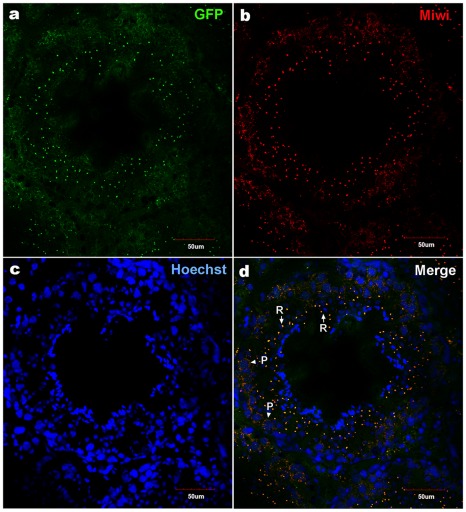
Co-localization of transgenic Miwi-EGFP and endogenous Miwi in transgenic mouse.Transgenic Miwi-EGFP and endogenous Miwi proteins in the Miwi-EGFP transgenic mouse testis were examined by indirect immunofluorescence and confocal microscopy using anti-GFP and anti-Miwi antibodies. Transgenic Miwi-EGFP (a) and endogenous Miwi (b) are nearly co-expressed in the cytoplasm of spermatocytes (P, arrowheads in panel d) and round spermatids (R, arrows in panel d), especially in round spermatids, both Miwi and GFP concentrate in the chromatoid body. Nuclei were stained using Hoechst33258 (blue). Green, transgenic EGFP; Red, endogenous Miwi; Merged image was showed in panel d. Negative controls were showed in Figure S1A.